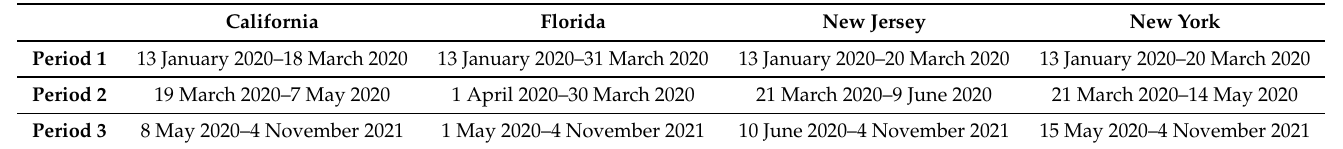
Table 2. Periods of different epidemic prevention policies in each